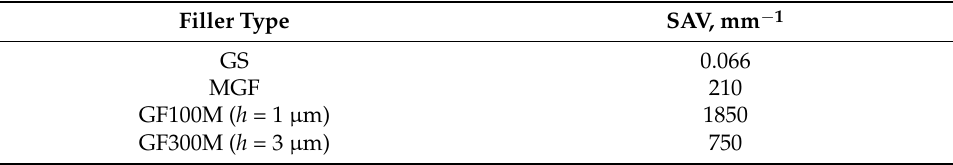
Figure 6. Dependency of elongation at break ( a ), Young’s modulus ( b ) and yield strength ( c ) from different types of the filler. Table 1. Surface area to volume ratio (SAV) for different filler